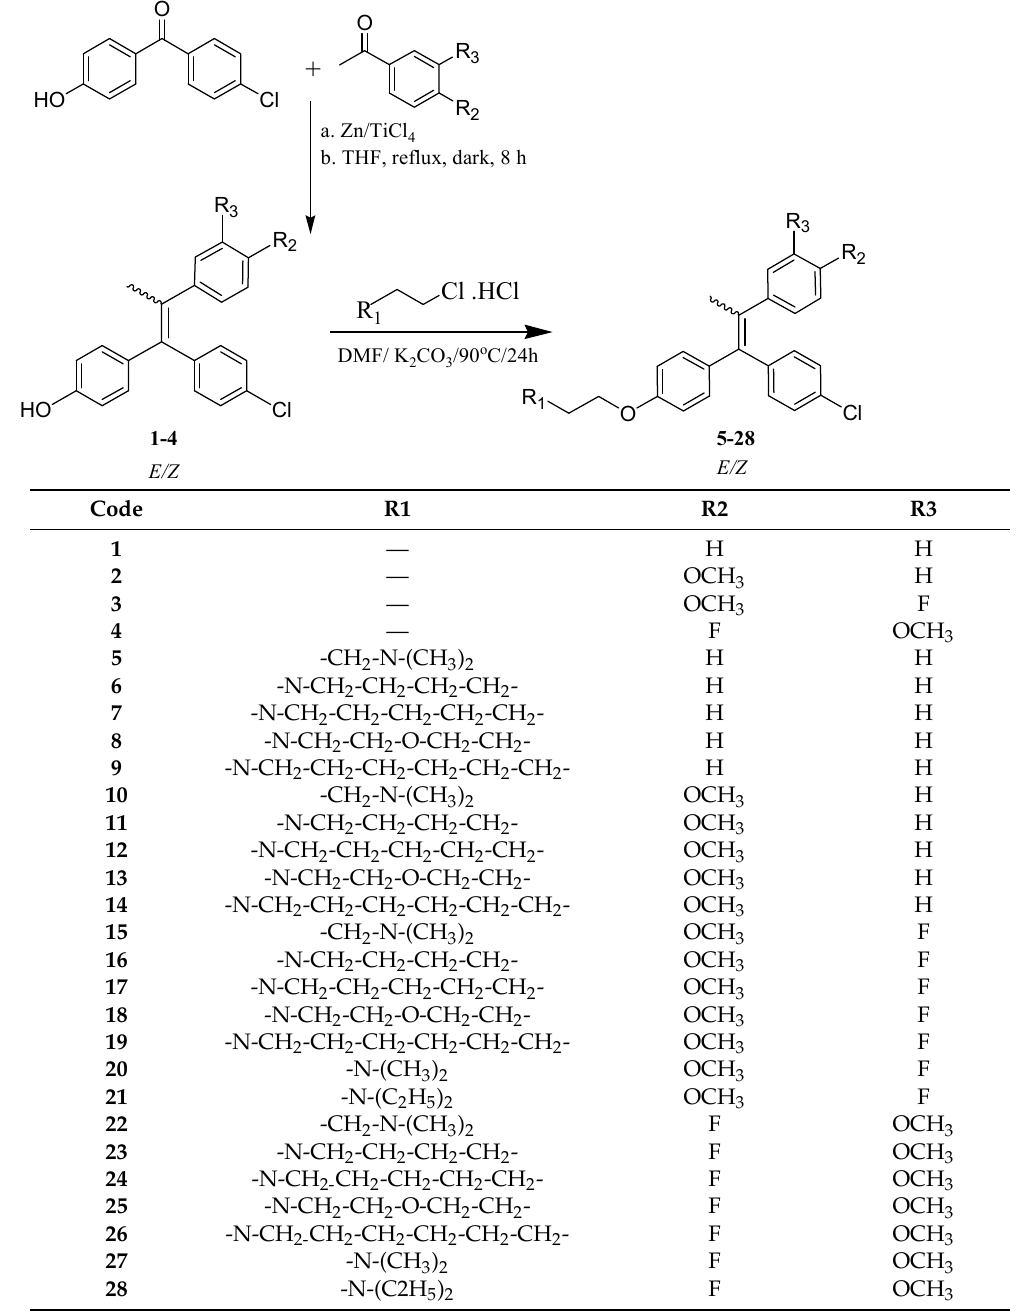
Table 1. Synthetic scheme: Preparation of compounds 1–28. O